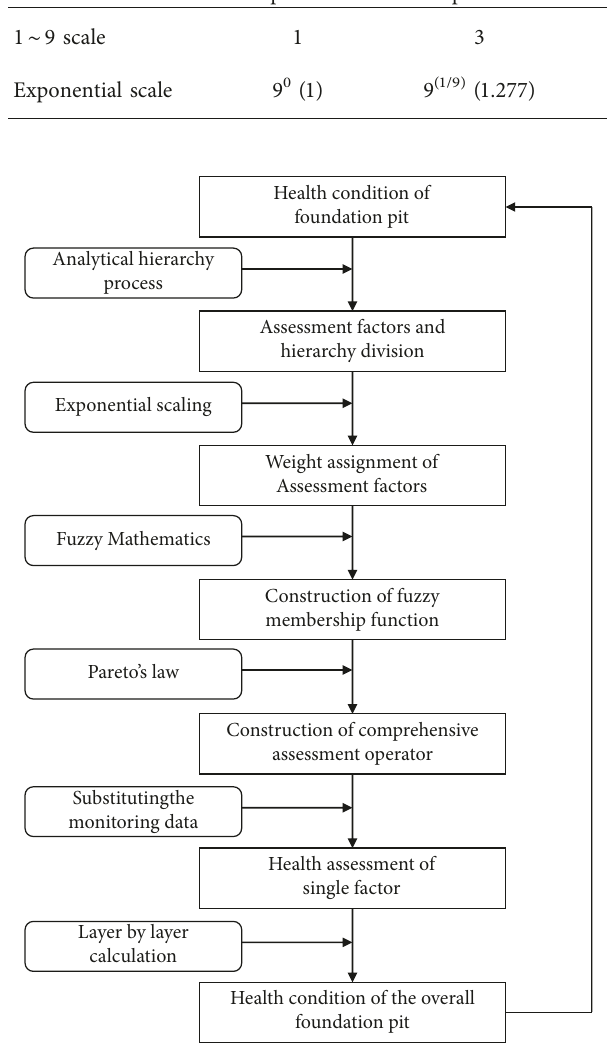
Figure 1: Health assessment process of foundation